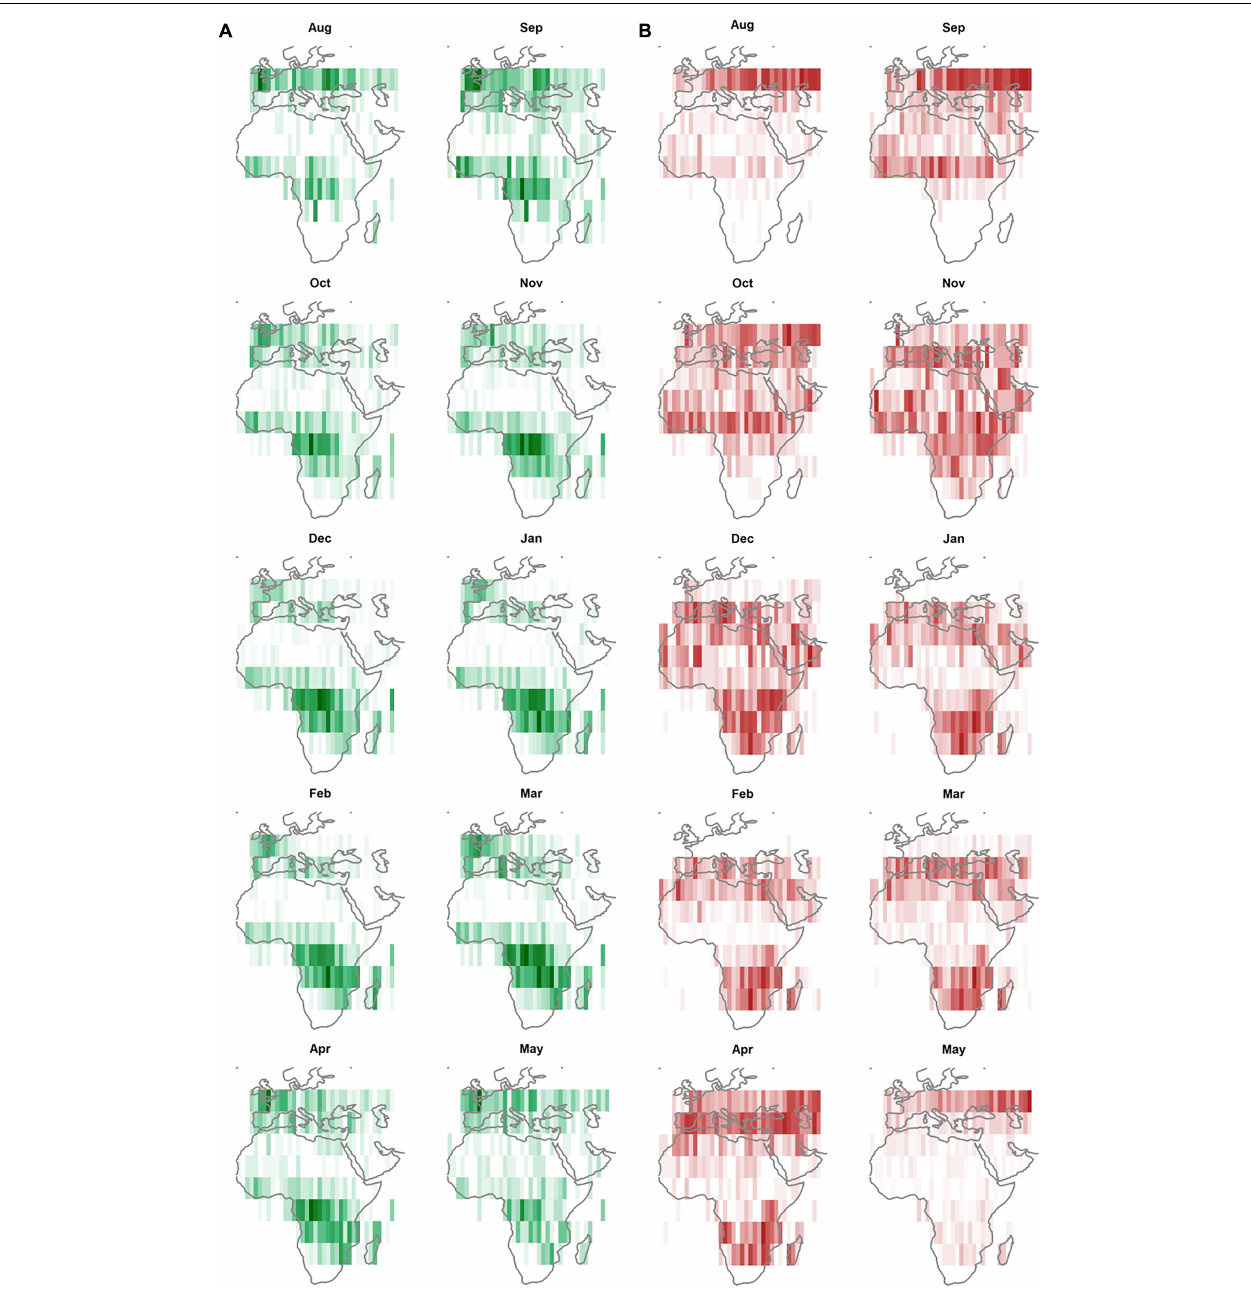
FIGURE 4 | Seasonal space use of highest NDVI and Surplus NDVI tracks. Count of cell use for high performance tracks aggregated every 10 ◦ of latitude south of the breeding site per month outside the defined breeding period: beginning June – end July. (A) Tracks with highest total NDVI of all those generated ( n = 740) and (B) total Surplus NDVI ( n = 640). Breeding sites are excluded from